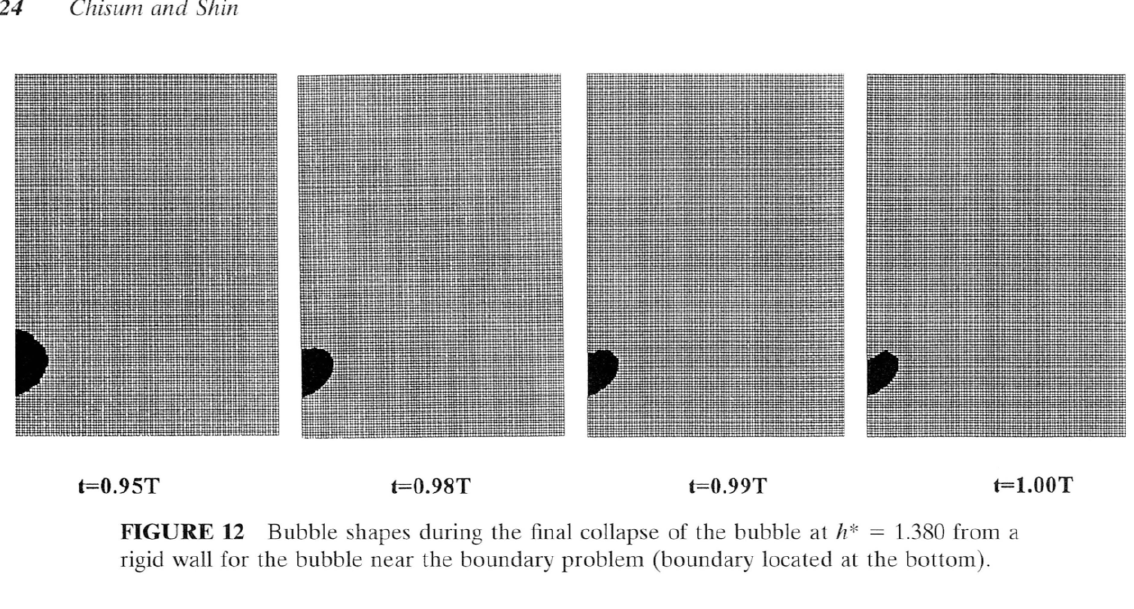
FIGURE 12 Bubble shapes during the final collapse of the bubble at h* = 1.380 from a rigid wall for the bubble near the boundary problem (boundary located at the